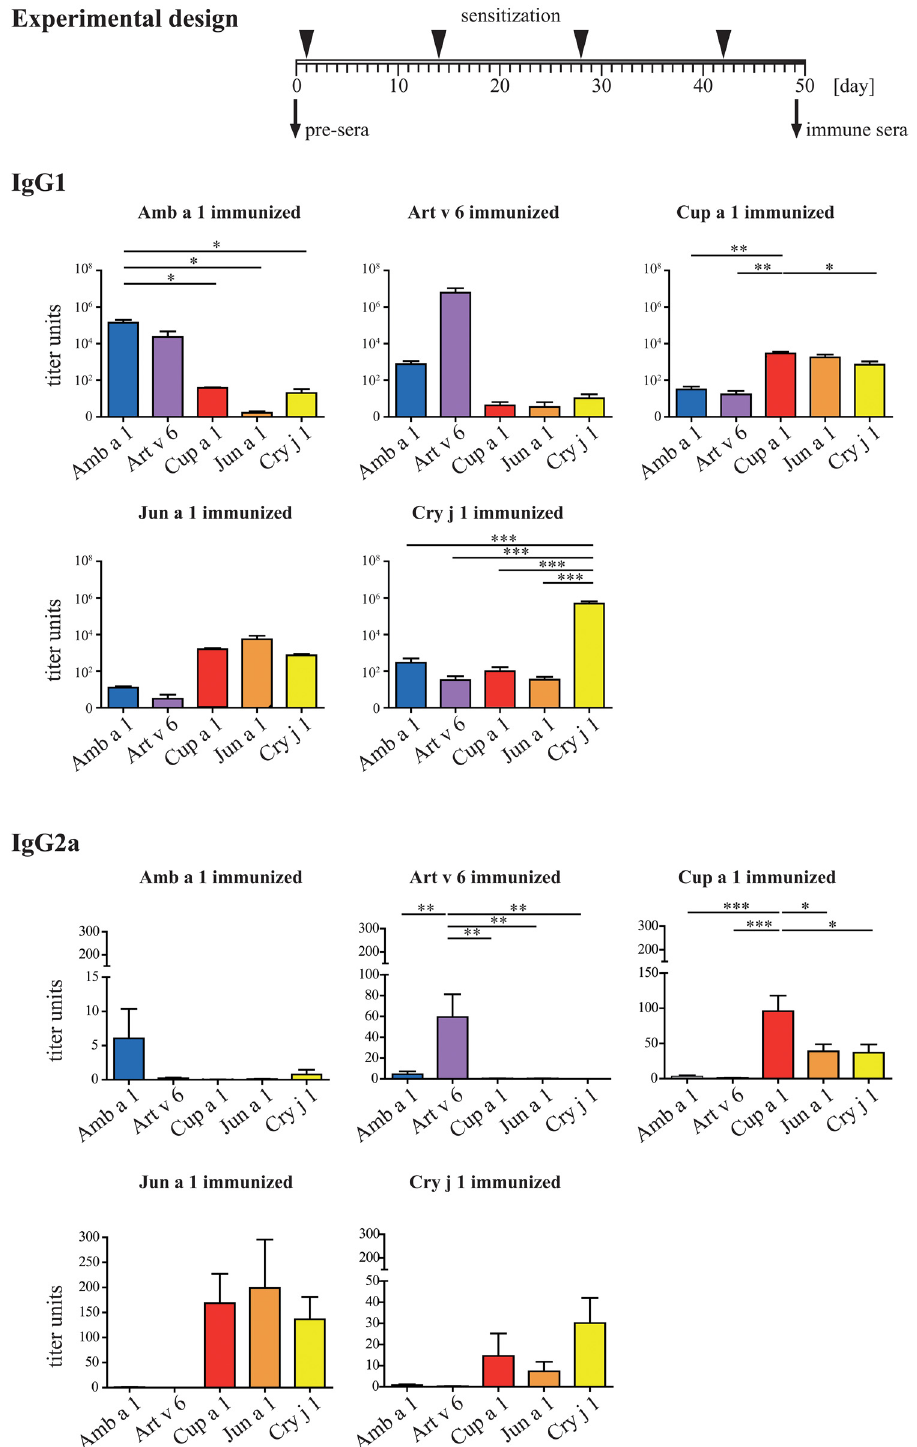
Fig 6. Humoral analysis of murine immune sera. The immunization scheme is presented as timeline, at each time point animals were immunized with 5 μ g antigen adsorbed to Alu-Gel-S. Sera were drawn at day 0 and 49, respectively. Levels of allergen-specific IgG1 and IgG2a of mice (n = 5/ group) immunized with either Amb a 1, Art v 6, Cup a 1, Jun a 1, or Cry j 1 at day 49 were analyzed by ELISA. Titers are displayed as bars ± SEM. Statistical analysis was performed with One-way ANOVA and Tukey´s Multiple Comparison Test ( * P < .05, ** P < .01, *** P <